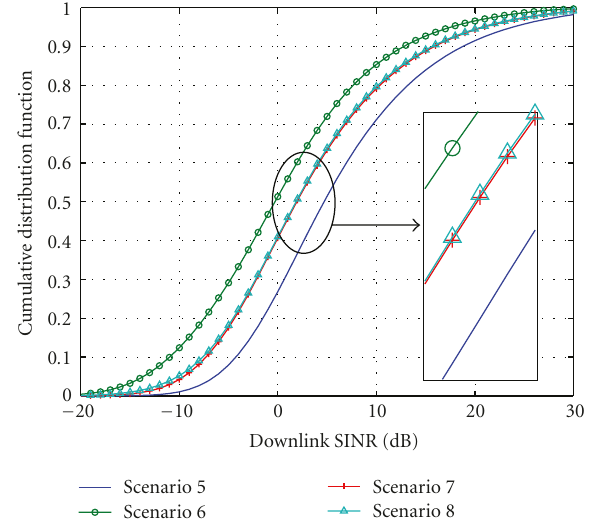
Figure 8: CDF of SINR with uncoordinated BS transmission power (FW method, σ X